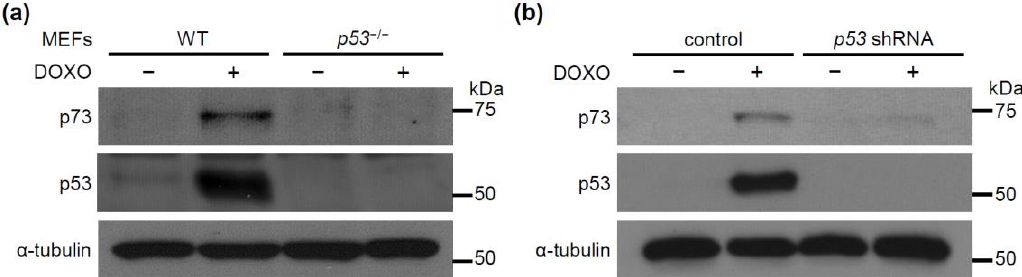
Figure 3. DOXO treatment induces p73 expression in a p53 dependent manner. ( a ) WT ( p53 +/+ ) and p53 −/− MEFs were treated with DOXO (0.5 μ g/mL) for 16 h. ( b ) MCF-7 cells infected either with control or p53 shRNA-expressing retrovirus were treated with DOXO (1.0 μ g/mL) for 16 h. Cell lysates were subjected to immunoblot analysis with antibodies against p73, p53, and α -tubulin as a loading control.